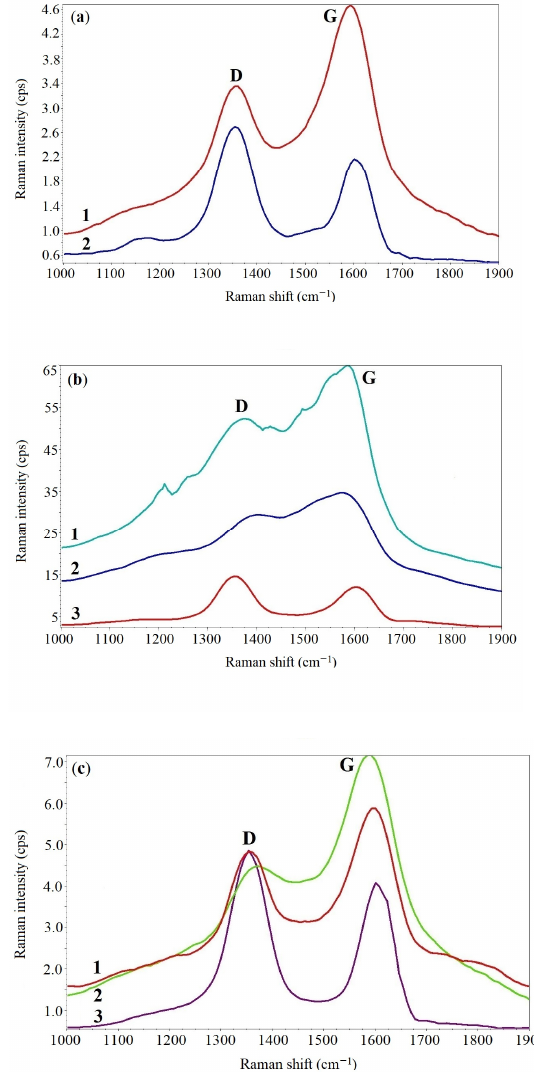
Figure 5. Raman spectra of films obtained from aqueous dispersions of ShC nanoparticles ( a ) and hybrids ShC-Ag ( b ), ShC-Au ( c ) after irradiation: (a) ShC-1—ns, 2—CW; (b) ShC-Ag, 1—ns irradiated, 2—fs irradiated, 3—CW; ( c ) ShC-Au, 1—ns, 2—fs, 3—CW. G and D are the typical Raman spectrum bands of carbon materials.